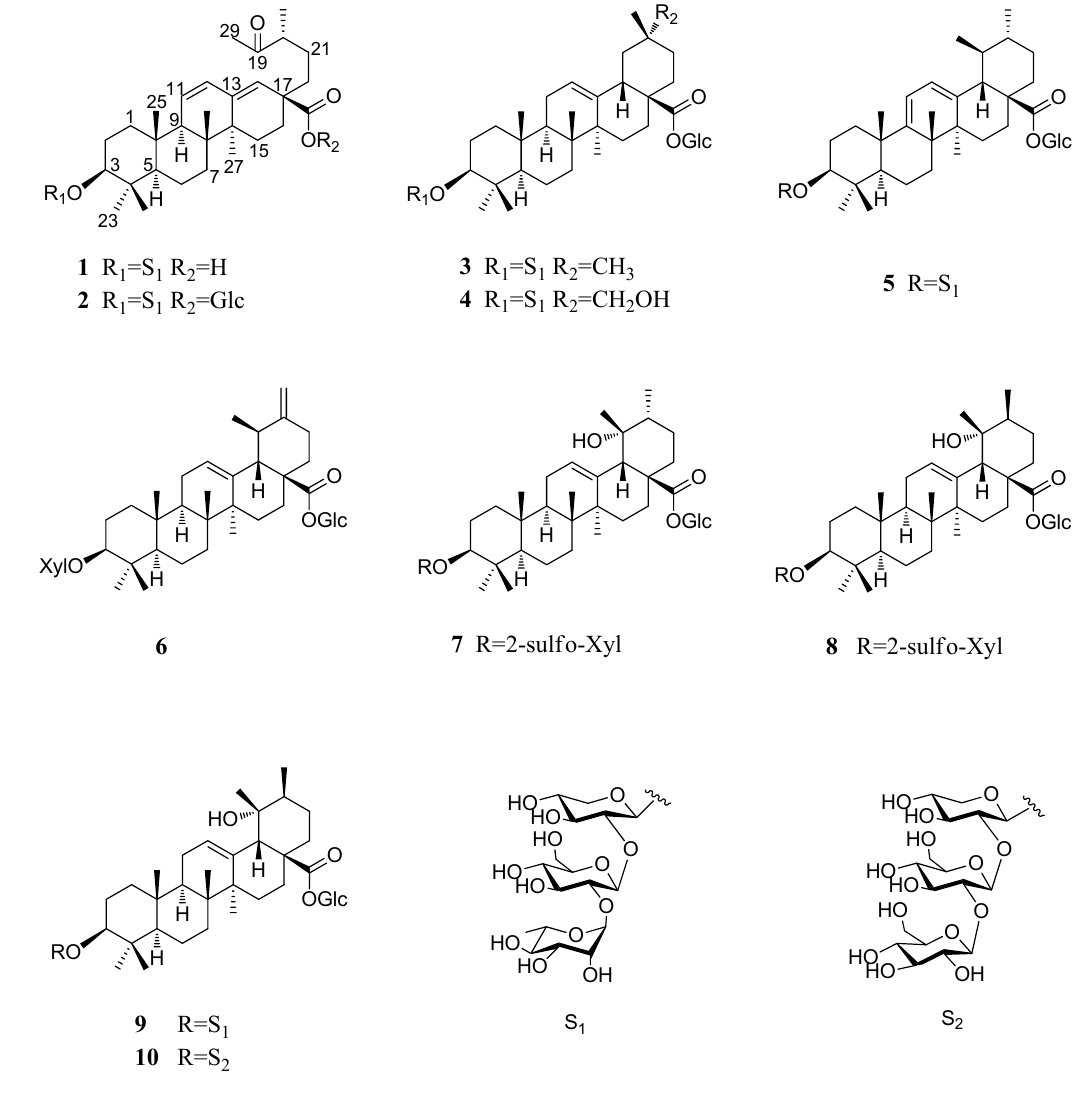
Figure 1. Structures of compounds 1 – 10 .